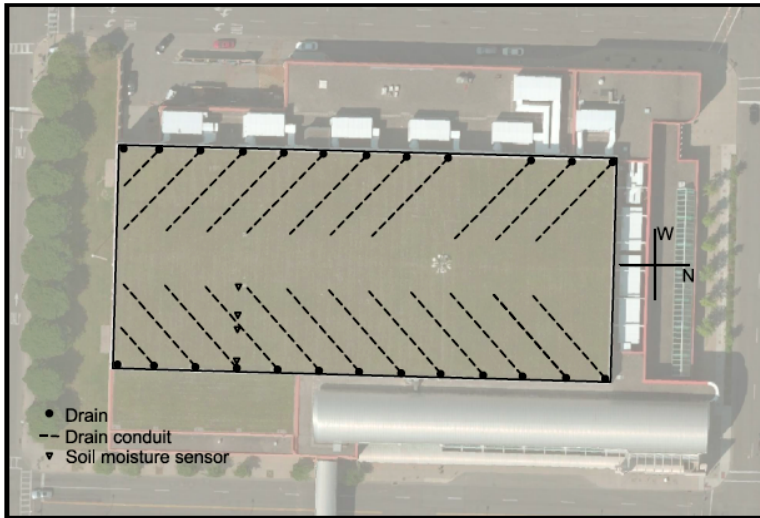
Figure 1. Location of roof drains and drain conduits on the OnCenter green roof. Soil moisture sensors located along a transect on the eastern side of the roof are shown.